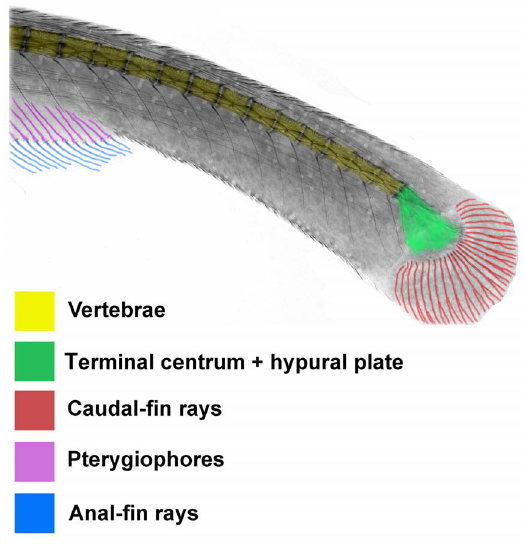
Figure 2. Radiographic image of caudal fin in Platyurosternachus macrostoma, INHS 28720, 250 mm TL. Color coding indicates components of caudal-fin skeleton, caudal-fin rays and posterior portion of anal